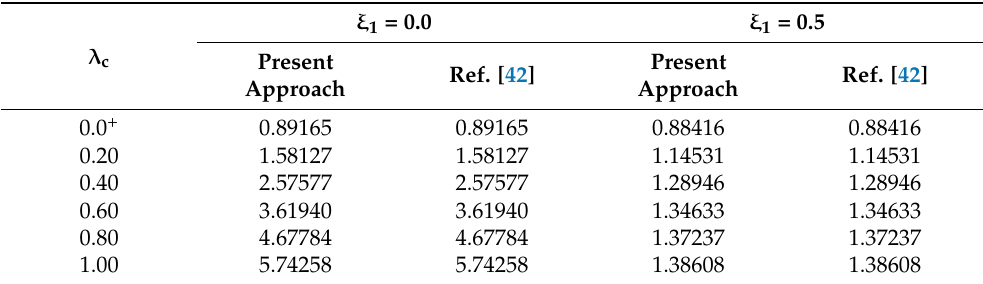
Table 5. Linear dimensionless natural frequencies of porous FG clamped–clamped (C–C) nano-beam